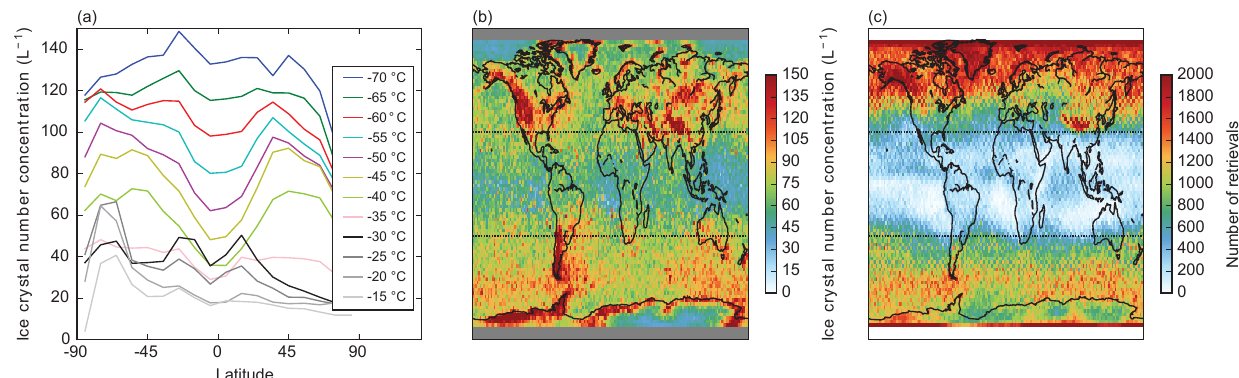
Figure 1. (a) The zonal mean DARDAR-Nice cloud top N i ( N 5µm DARDAR-Nice data for the period from 2006 to 2013. Temperatures warmer than − 35 ◦ C are in greyscale. (b) The mean N 5µm Grey indicates missing data. (c) The number of cloud top retrievals at − 50 ◦ C. Zonal means and maps of N i are available in Part 1.